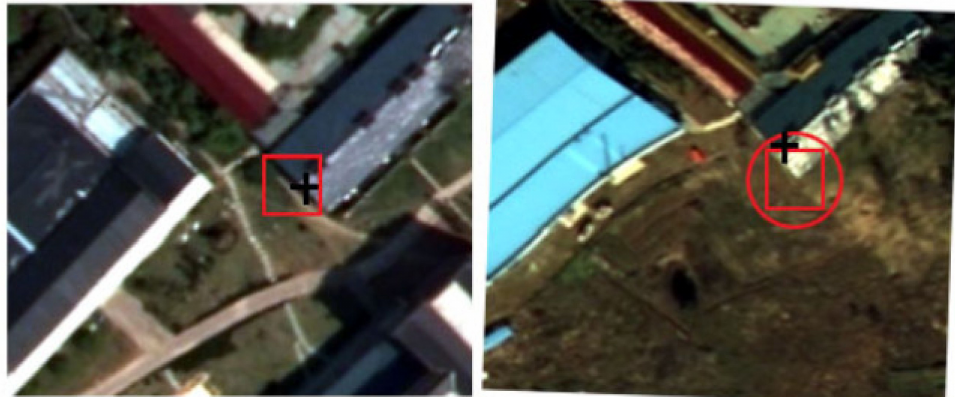
Figure 2. Position deviation of the identical ground object in the red